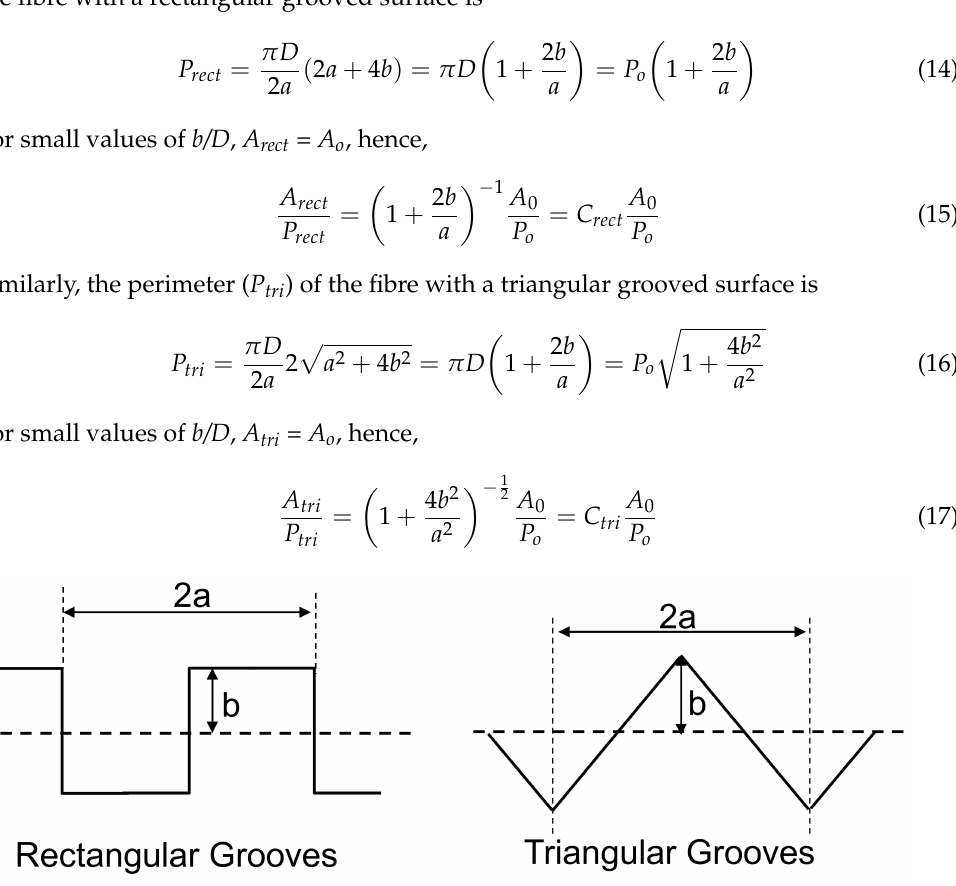
Figure 14. Geometrical models of carbon fibre surface